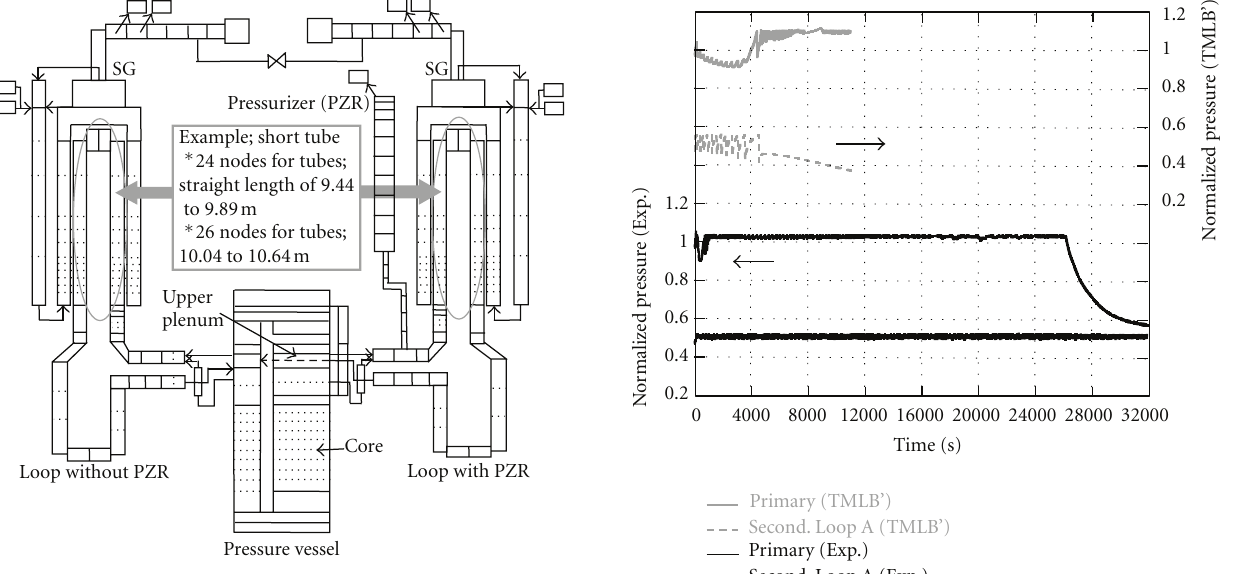
Figure 23: Noding schematic of LSTF for RELAP5 analysis.